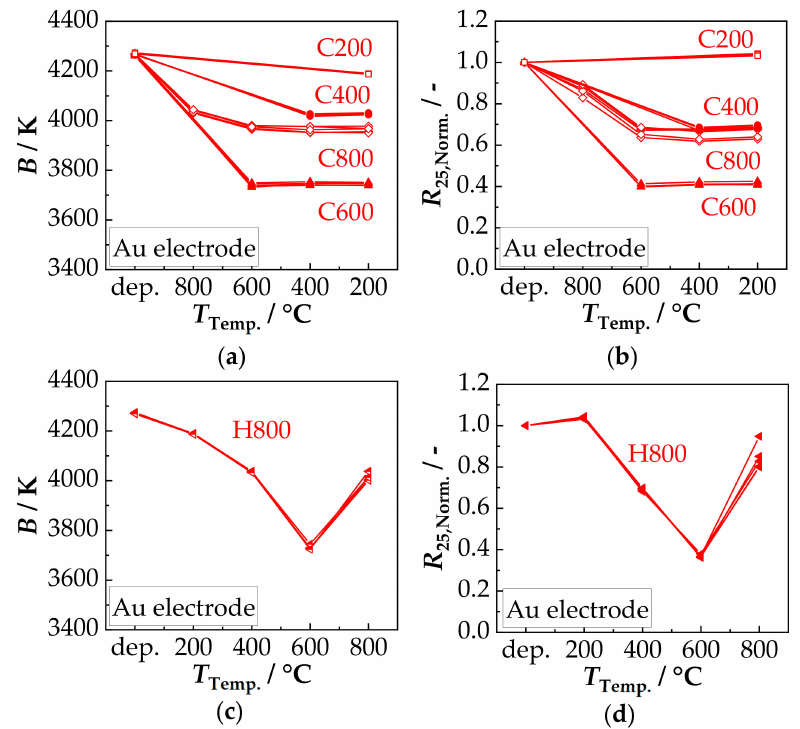
Figure 7. Tempering-related change of ( a ) B and ( b ) R 25,Norm. in the as-deposited state (dep.) and after the cycle C800, C600, C400, C200; tempering-related change of ( c ) B and ( d ) R 25,Norm. in the as-deposited state and after the cycle H800 of the NTCR devices with Au